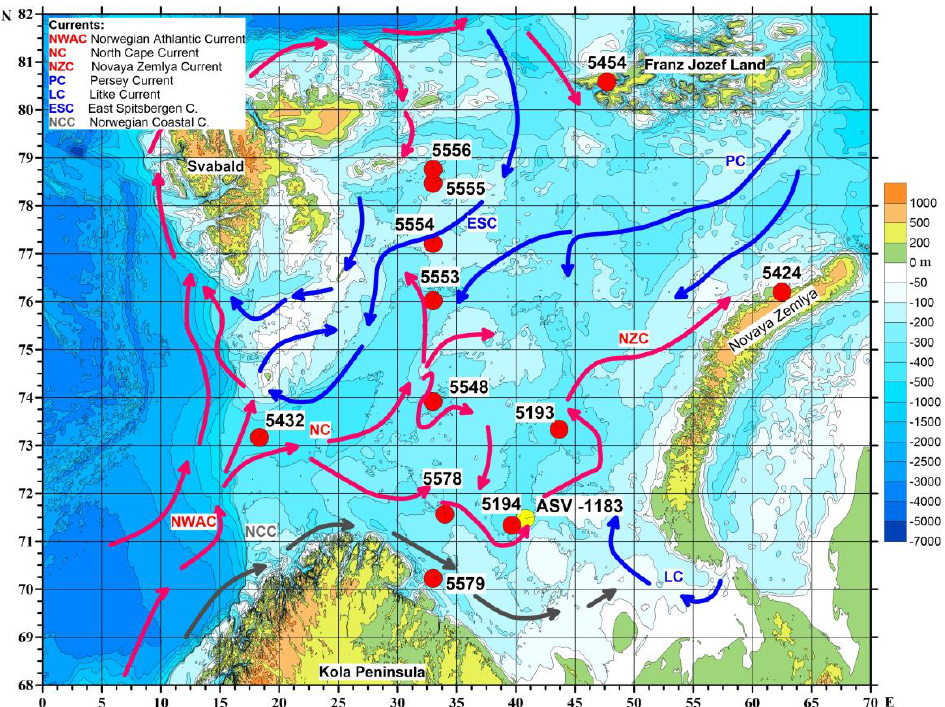
Figure 1. Scheme of location of sampled corer and directions of surface currents in the Barents Sea. Red and blue arrows mean relatively warm and cold currents, respectively.